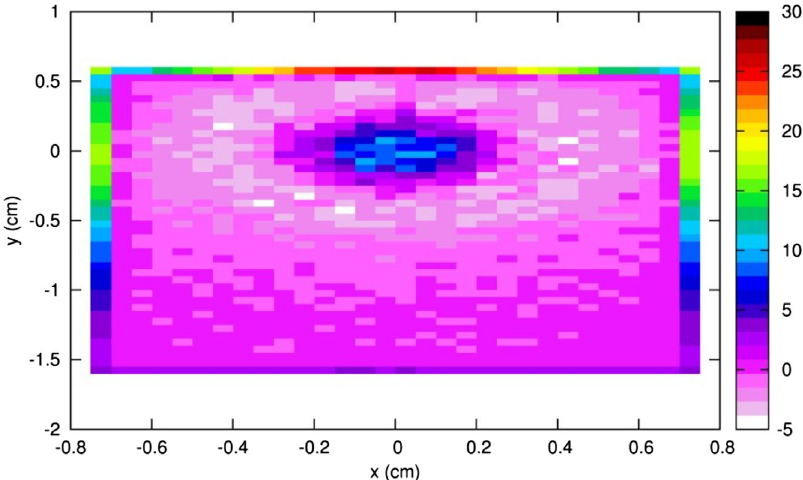
FIG. 12. Net deposited charge in the powder sample following the proton beam pulse calculated using FLUKA shown at plane AA [charge/cc/proton].